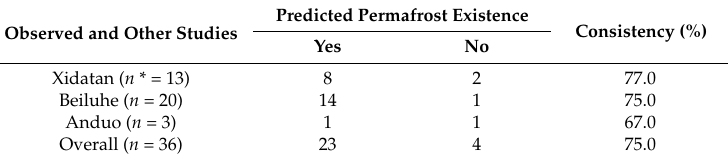
Table 7. Comparison of direct permafrost observations.